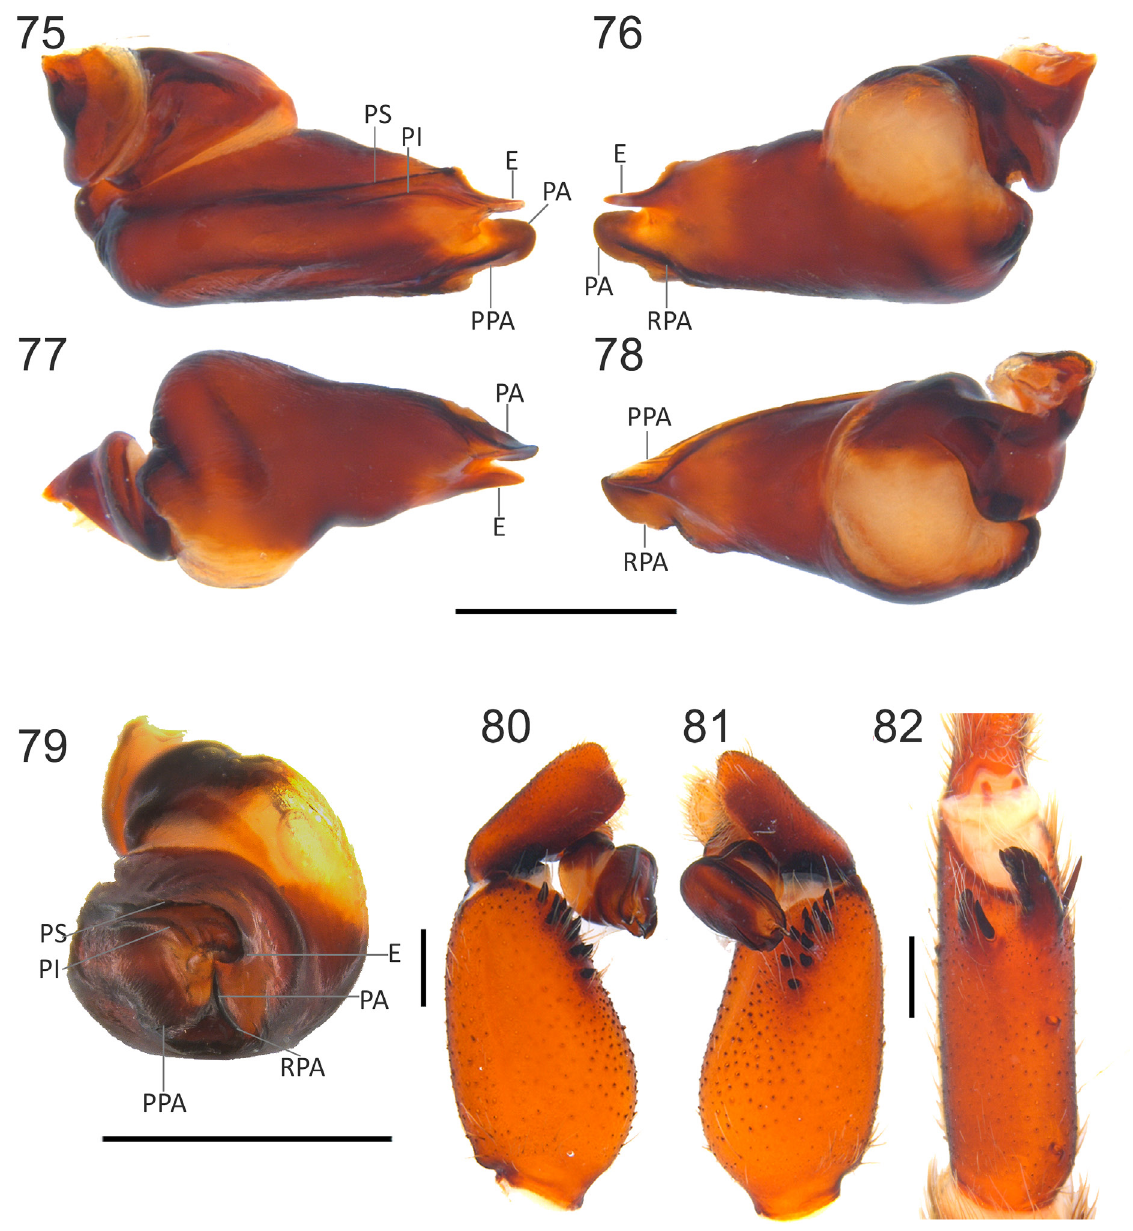
Figs 75–82 . Schismatothele wayana sp. nov., holotype, ♂ (MPEG 7363). 75–79 . Palpal bulb, prolateral (75), retrolateral (76), ventral (77), dorsal (78), and frontal (79) views. 80–81 . Palpal tibiae, right (80), and left (81). 82 . Tibial spur, ventral view. Abbreviations: E = embolus; PA = paraembolic apophysis; PI = prolateral inferior keel; PPA = prolateral paraembolic keel; PS = prolateral superior keel; RPA = retrolateral paraembolic keel. Scale bars = 0.5